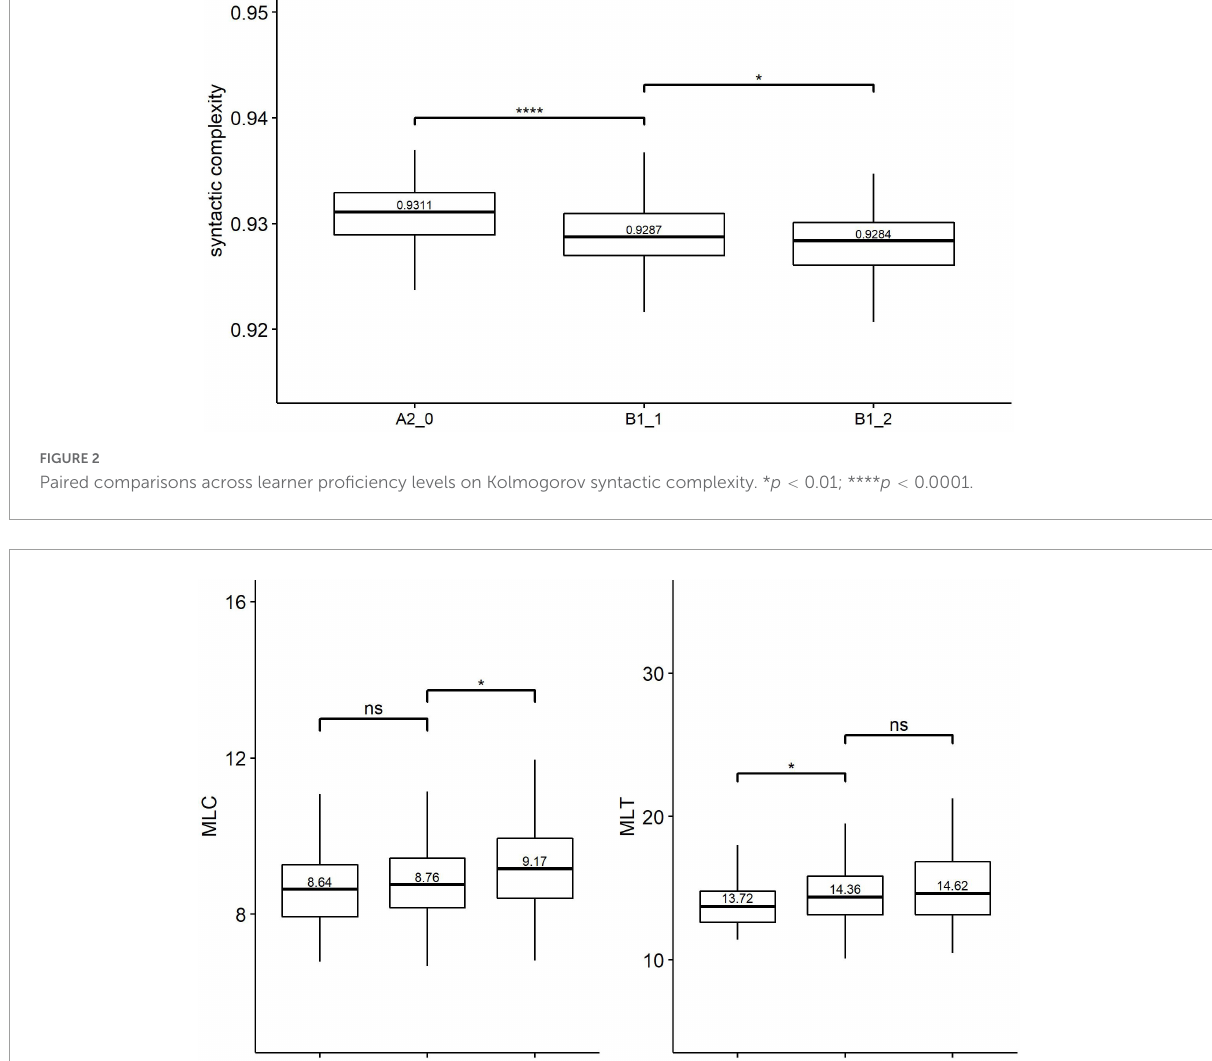
levels: beginner level (A2_0) vs. lower-intermediate level